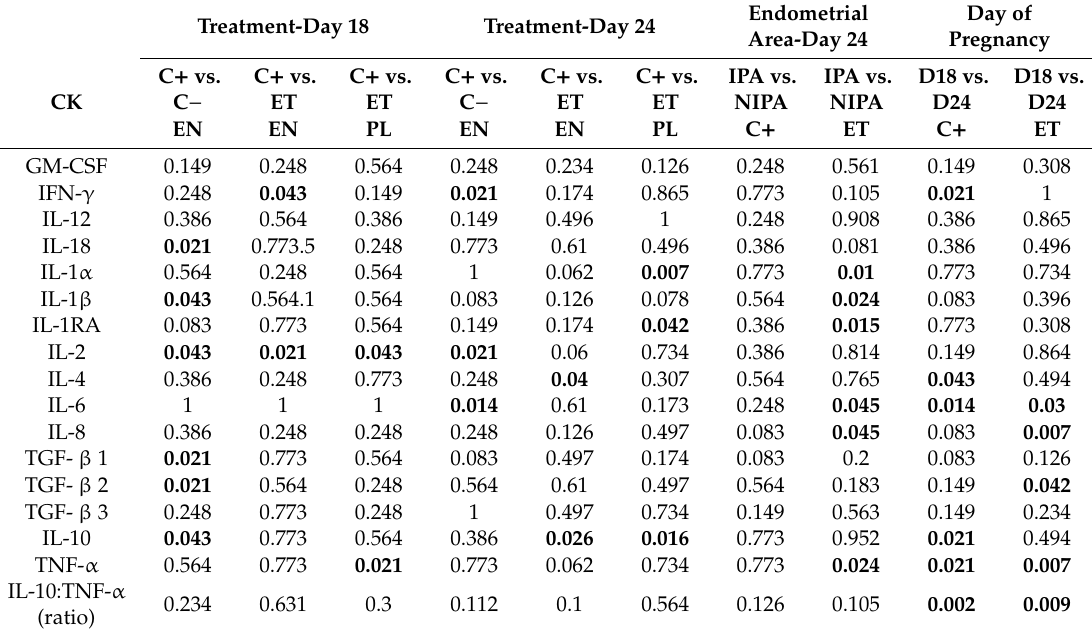
Table 3. Statistical di ff erences ( p -value, statistically di ff erent in bold) in cytokine levels among all groups and experimental conditions.